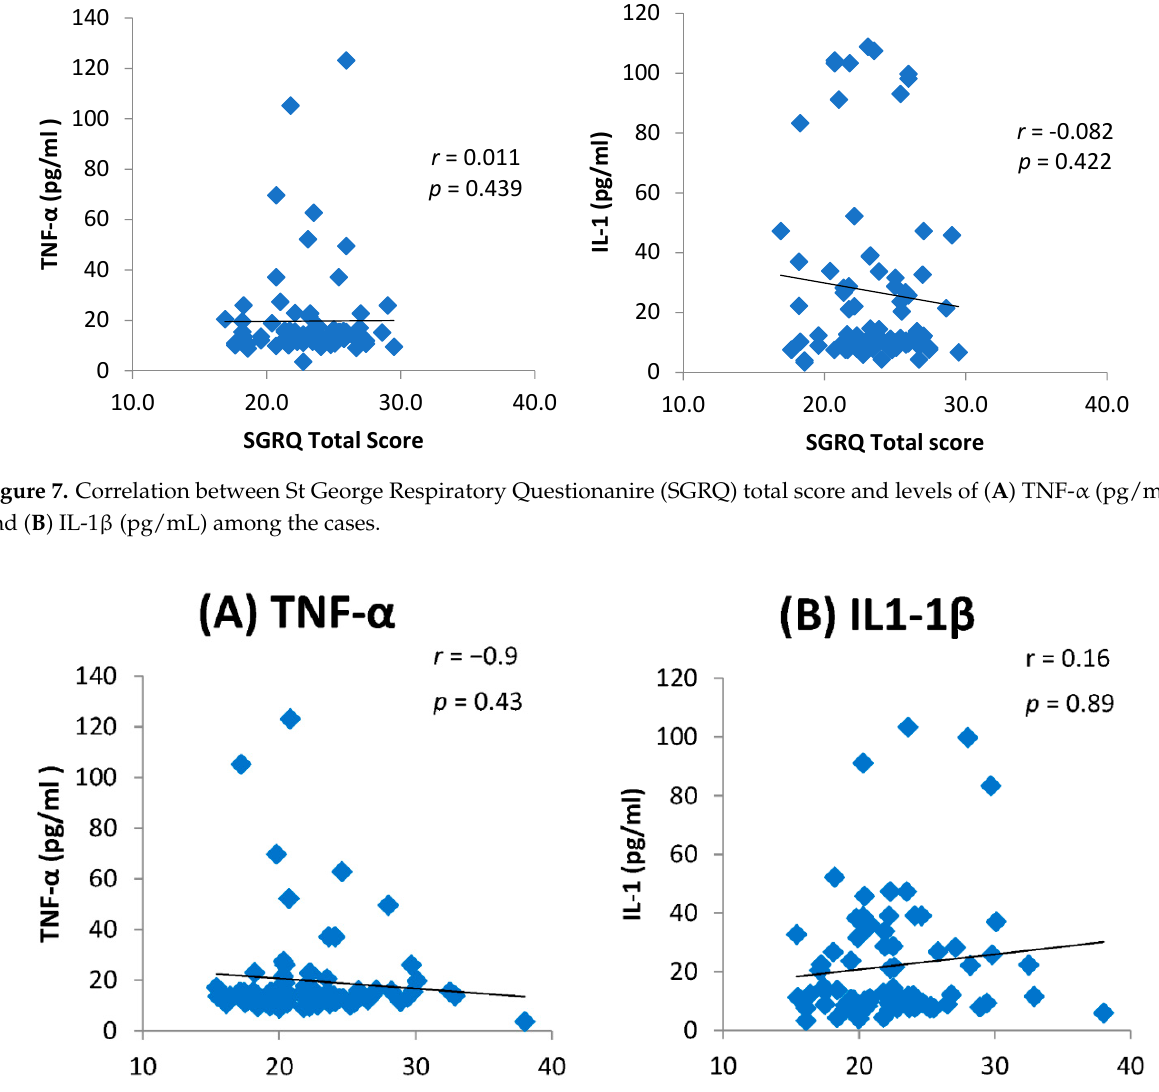
Figure 8. Correlation between SGRQ total score and levels of ( A ) TNF- α (pg/mL) and ( B ) IL-1 β (pg/mL) among the cases. BMI: Body mass index. Table 1. Demographic and clinical details of COPD cases and controls in the study.